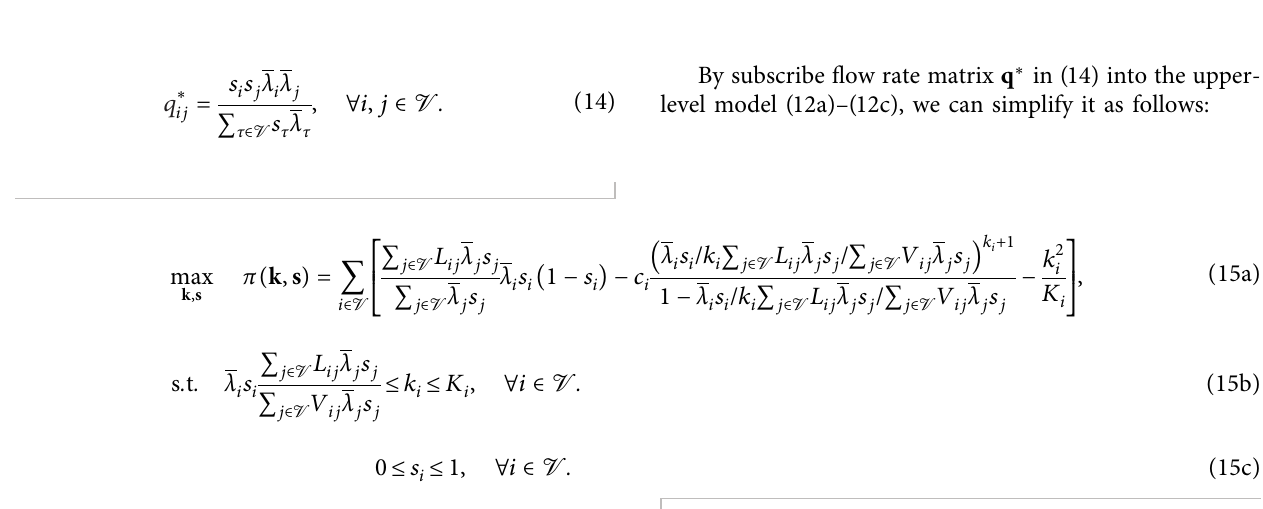
Figure 1: The state transition process of a double queuing